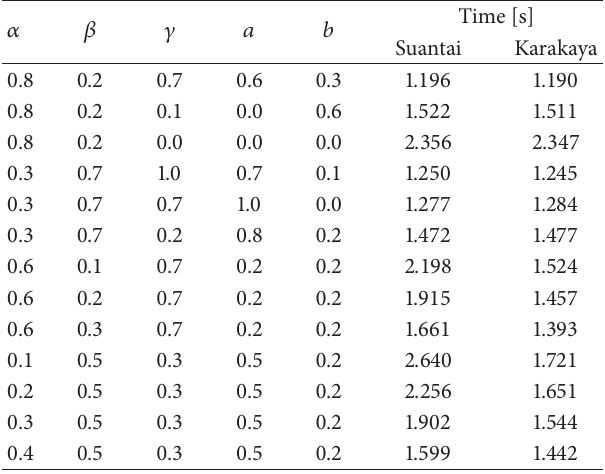
Table 9: Times of polynomiograph’s generation for 𝑝 2 using five parameters